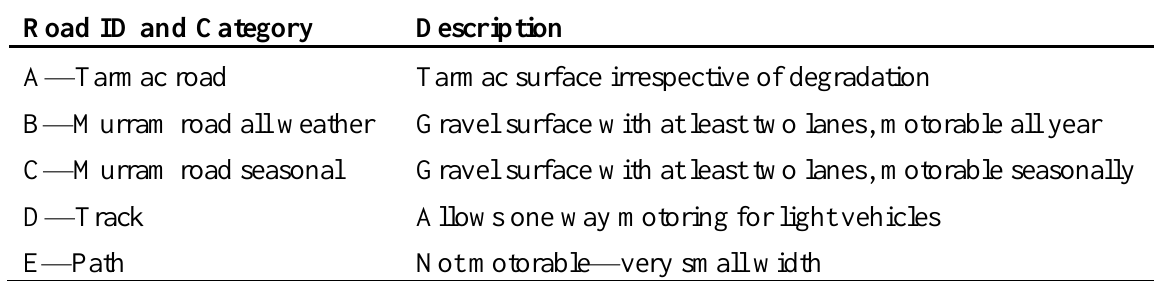
Table 2. Description of road classes used in the Survey of Kenya topographic maps.